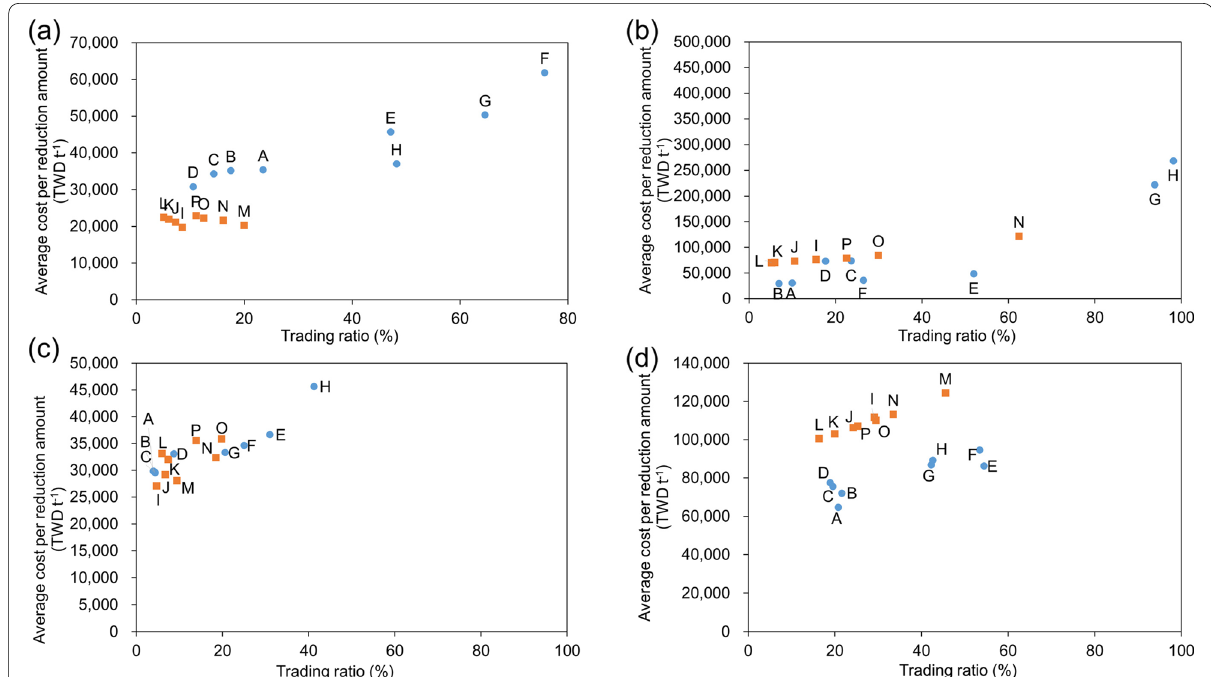
Fig. 5 Comparison diagram of the average cost per reduction amount and trading ratio for ( a ) particulate matter (PM), ( b ) SO x , ( c ) NO x , and ( d ) volatile organic compounds (VOCs) in each simulation